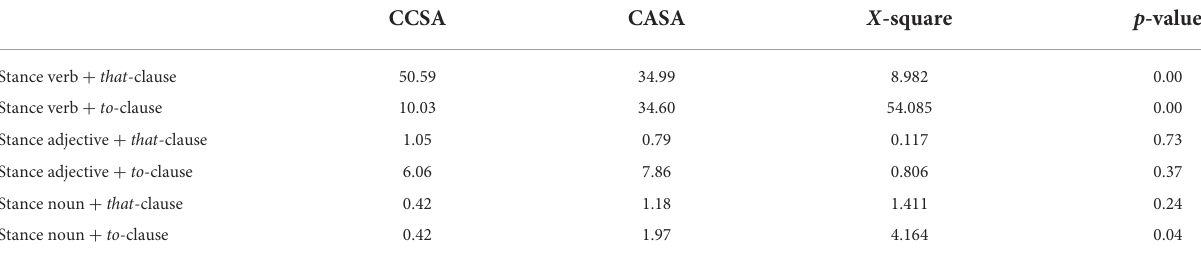
TABLE 6 Normalized frequencies (per 10,000 words) of each class of stance-complement clauses in CCSA and CASA. CCSA CASA X -square p -value